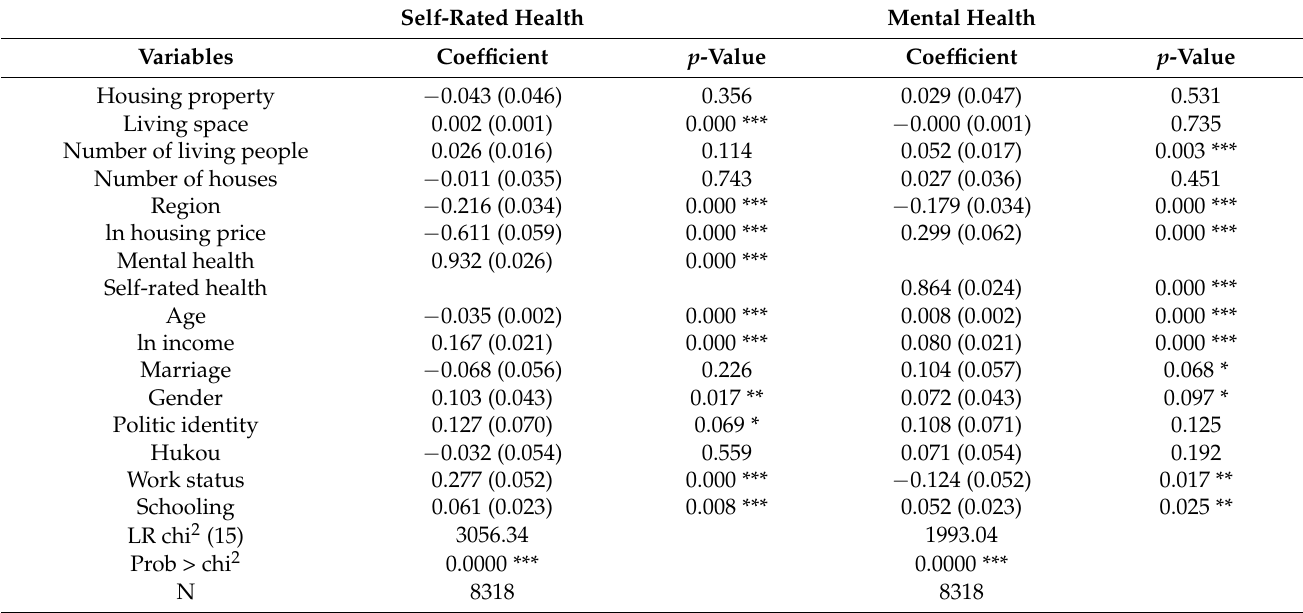
Table 2. Results for full sample ordered logistic